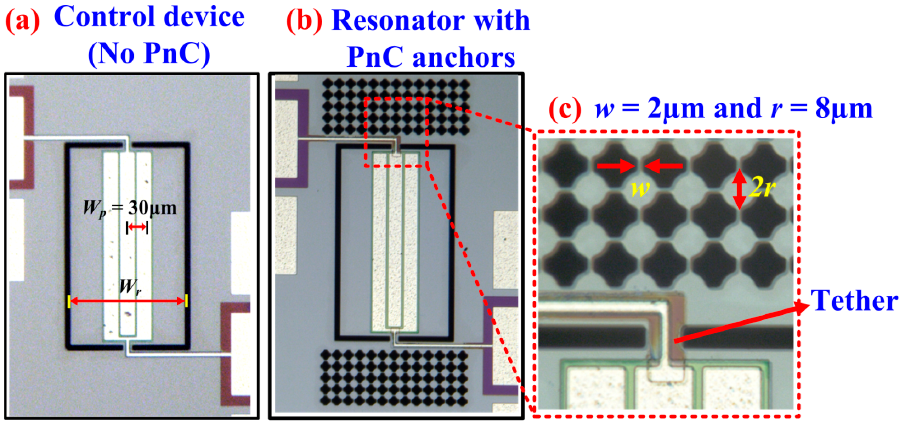
Figure 5. Optical micrographs of the fabricated devices partially covered with 3 IDT fingers: ( a ) Control device with no PnCs, ( b ) PnC bounded resonator, and ( c ) close-up view of the PnC matrix in relation to the Lamb mode resonator connected through the tether whose width was kept to the minimum allowed by the